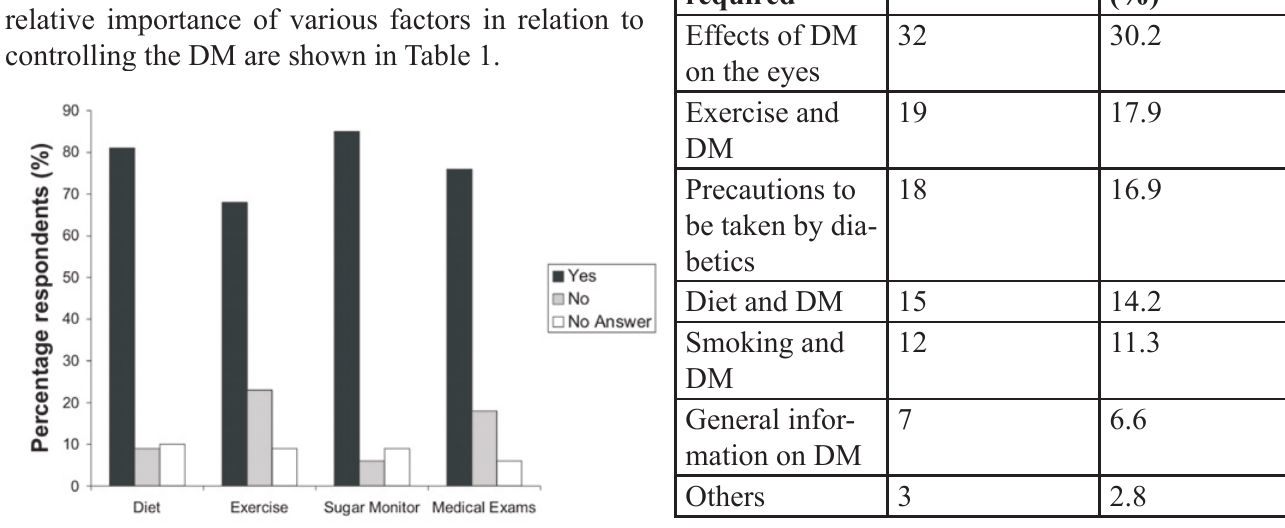
Figure 2: Percentage of respondents on the knowledge of the different modes of DM control. Many of the subjects had good knowledge of management protocols for DM. Table 1: The various percentage ratings of factors that are in- volved in the management of DM. The majority of the respond- ents rated regular blood sugar monitoring and medication as very important factors.